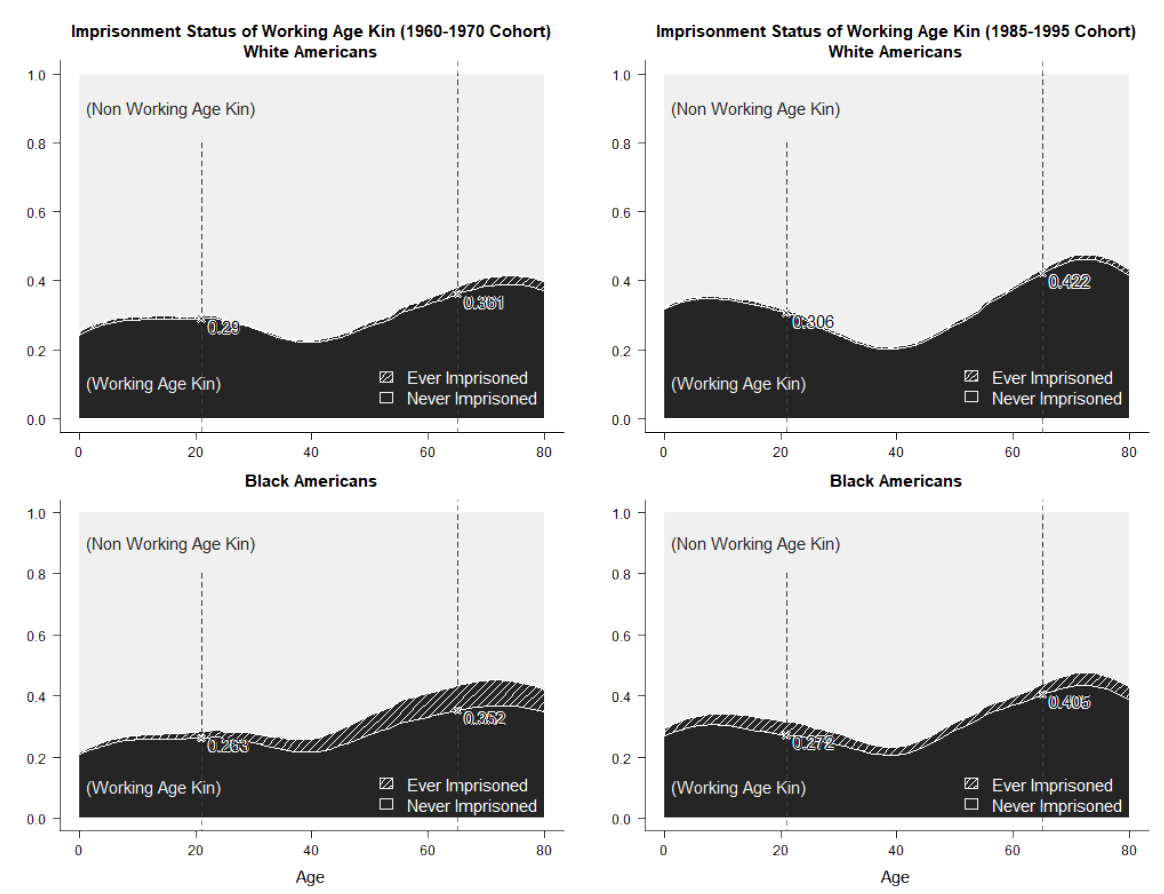
Figure 4: Cohort-specific availability of never-incarcerated, working age (25–54 years old) kin. The top plots illustrate the proportions of working-age kin for white individuals, whereas the bottom plots illustrate the same for black individuals. The shaded regions indicate the share of working-age kin who have ever been incarcerated. Points marked by x’s indicate the proportion of kin who are working age and have never been incarcerated when ego is age 21 and